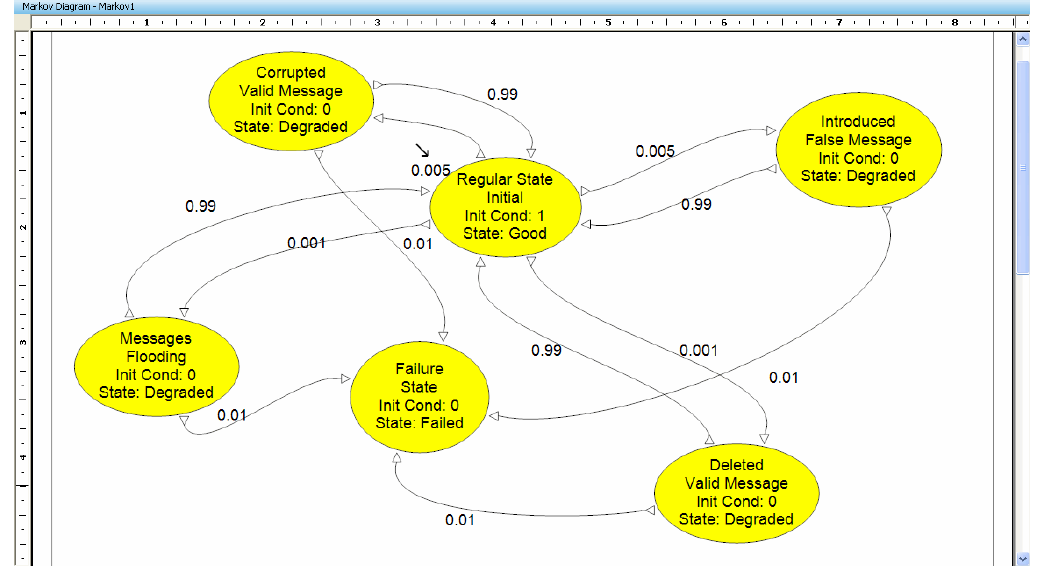
Figure 8. Markov model of the CACC system (no repairs). Init Cond: is 1 (true) for the initial state and 0 (false) for non-initial state (it is just a notation of the used tool).